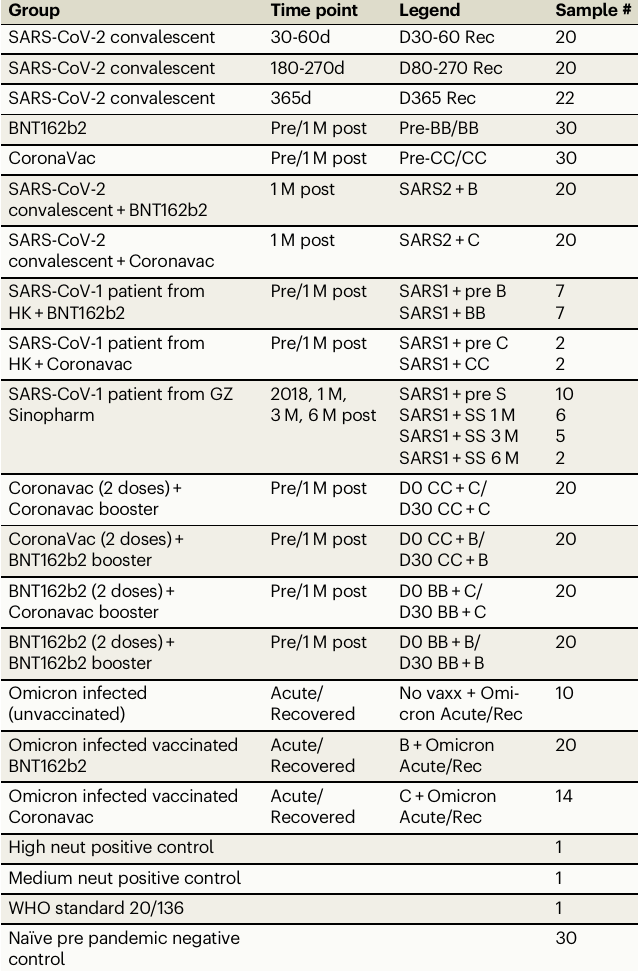
Table 1 | Samples used in sVNT assay Group